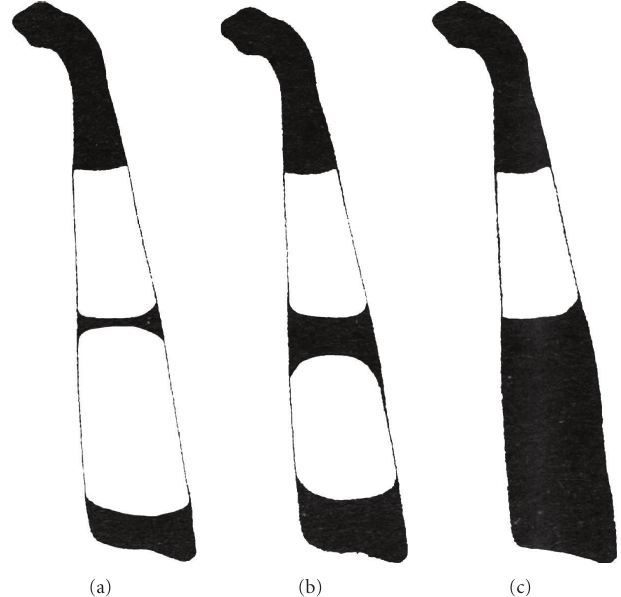
Figure 3: Variants of coloring of a tibia distal segment in I. maculator F. adults